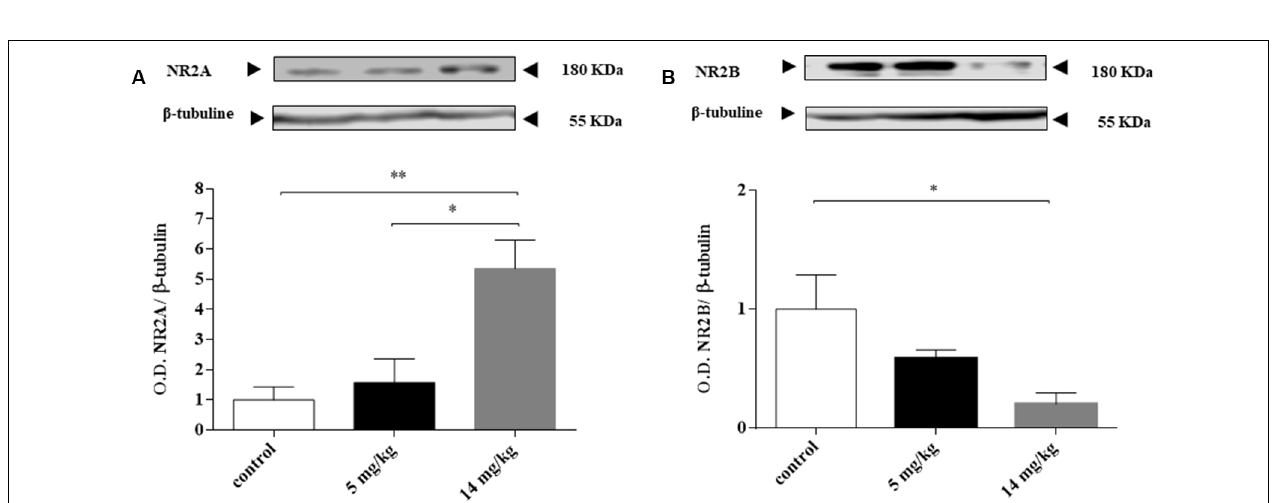
FIGURE 3 | Inorganic arsenic (iAs) effect on the protein levels of the N -methyl-D-aspartate receptor (NMDAR) subunits NR2A (A) and NR2B (B) in the cortex of mice treated with 0, 5, or 14 mg/kg NaAsO 2 . Changes in the protein levels in the enriched membrane fraction were evaluated by Western blot analysis 24 h after the last NaAsO 2 administration. Bars show the densitometric analysis of the protein bands normalized to β -tubulin, mean ± SE n = 6. The data were analyzed using one-way ANOVA with Tukey’s post hoc analysis. Different superscript symbols above each column indicate statistically significant differences; ∗ P ≤ 0.05, ∗∗ P ≤ 0.01.